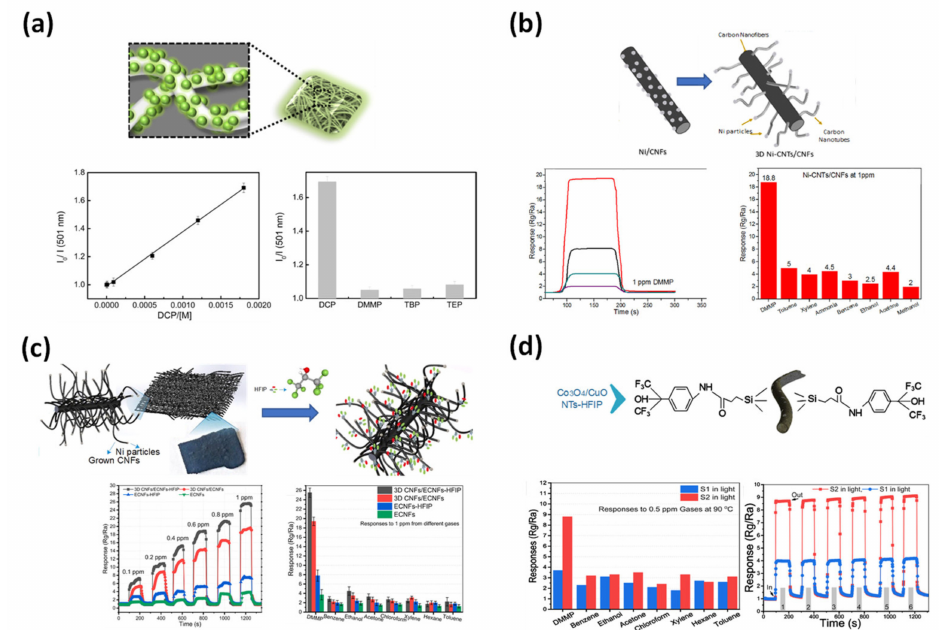
Figure 19. ( a ) CNFs carry quantum dots for diethyl chlorophosphate fluorescent detection [138]. ( b ) Cactus-like CNFs with Ni nanoparticles for detection of DMMP [140]. ( c ) Cactus CNFs modified with HFIP for DMMP sensor [141]. ( d ) CNFs/CuO/Co 3 O 4 with silicone coupling agent and HFIP for DMMP detection